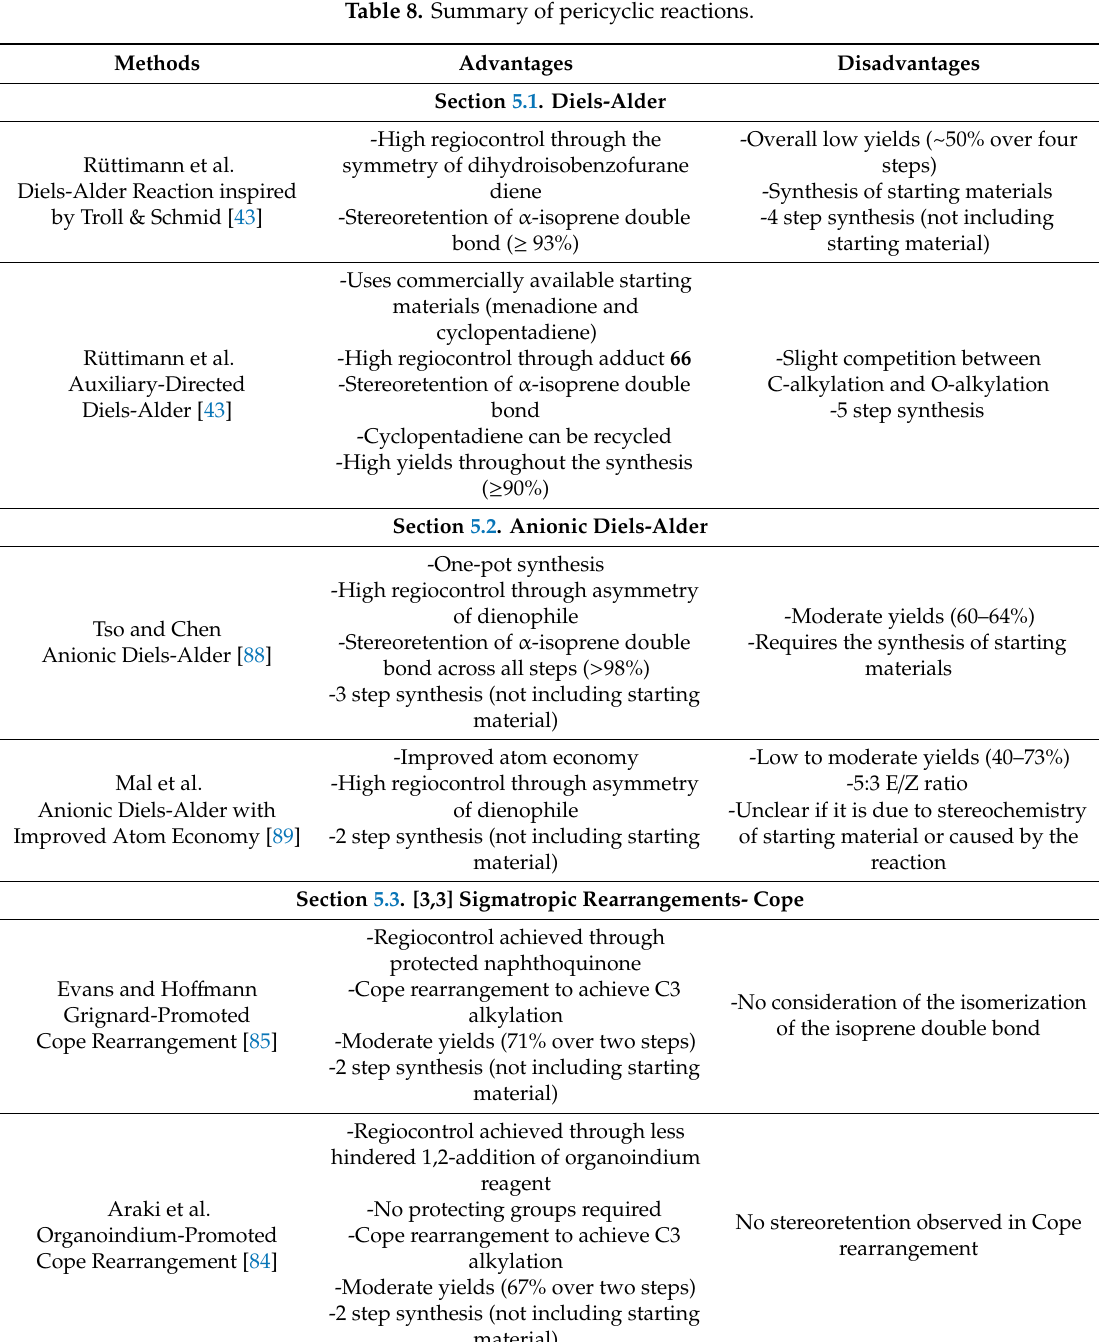
Table 8. Summary of pericyclic